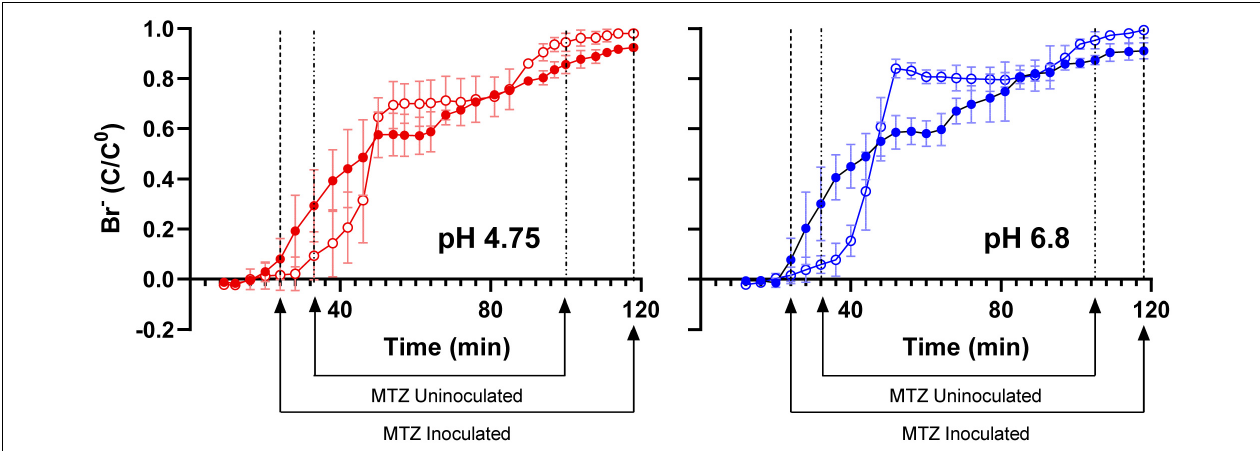
FIGURE 5 | Bromide breakthrough curves of sub muros -inoculated (closed shapes) and uninoculated (open shapes) columns after 63 days of operation. The columns that received the basal SPW pH 4.75 media are in red, with the SPW pH 6.8 in blue. Mass transfer zone (MTZ) lines represent initial breakthrough point where bromide-amended SPW is mixing with bromide-free SPW and adsorption exhaustion point where column is saturated with bromide-amended SPW. SPW was fed to columns at a rate of 0.2 mL/min. Error bars represent one standard deviation of triplicate